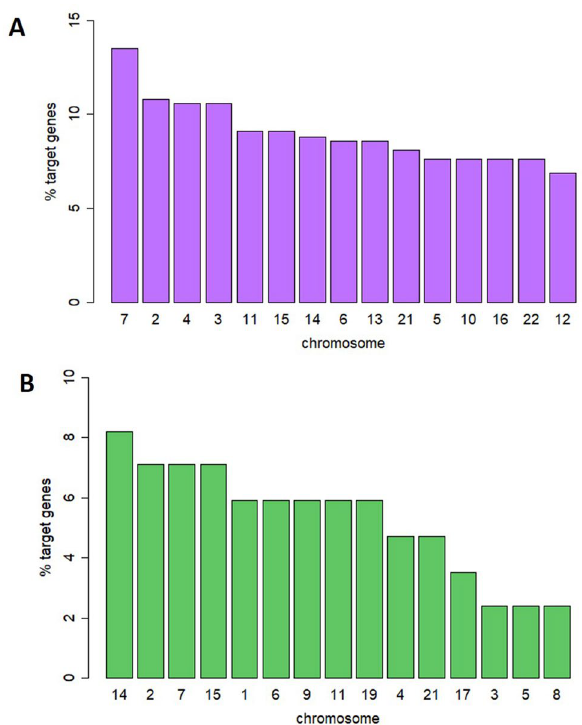
Figure 5. Chromosomal distribution in the zebrafish genome of the number of predicted target genes obtained from differentially expressed miRNAs after high temperature in the ovary ( A ) and testis ( B ) in adult